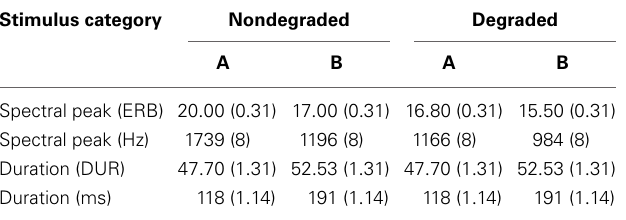
Table 1 | Means and standard deviations (in parentheses) of spectral peak and duration distributions for stimulus categories A and B in the nondegraded and degraded conditions (psychophysical and physical units).